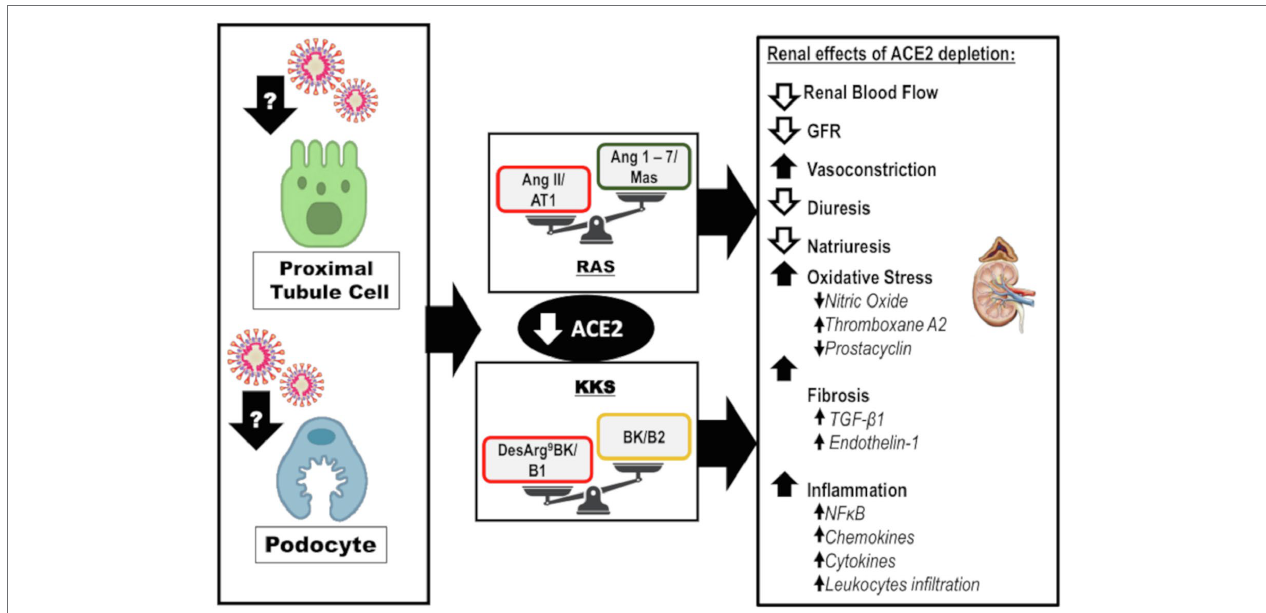
FIGURE 4 | Direct effects of SARS-CoV-2 on kidneys: Infection and disruption of the downstream mechanisms regulated by ACE2. It is likely that SARS-CoV-2 infects the kidney by directly targeting the proximal tubule cells and podocytes. The infection can lead to depletion of ACE2 and its biological functions at the intrarenal level, which may lead to exacerbated actions of the ACE/Ang II/AT1 axis of RAS and desArg 9 BK/B1 axis of KKS. This impairment leads to reduced renal blood flow, GFR, diuresis, and natriuresis. However, there is an increase in vasoconstriction. The oxidative stress is enhanced due to a decrease in NO levels, interfering in the balance between prostacyclin and thromboxane A2. Furthermore, fibrosis is enhanced in response to TGF- β 1 and endothelin-1. Finally, inflammation is upregulated along with augmented levels of chemokines, cytokines, and leukocyte recruitment. ACE2, angiotensin-converting enzyme 2; AT1, angiotensin II receptor type 1; BK, bradykinin; desArg 9 BK, desArg 9 bradykinin; B1, kinin receptor type 1; B2, kinin receptor type 2; GFR, glomerular filtration rate; KKS, kallikrein-kinin system; and RAS, renin-angiotensin